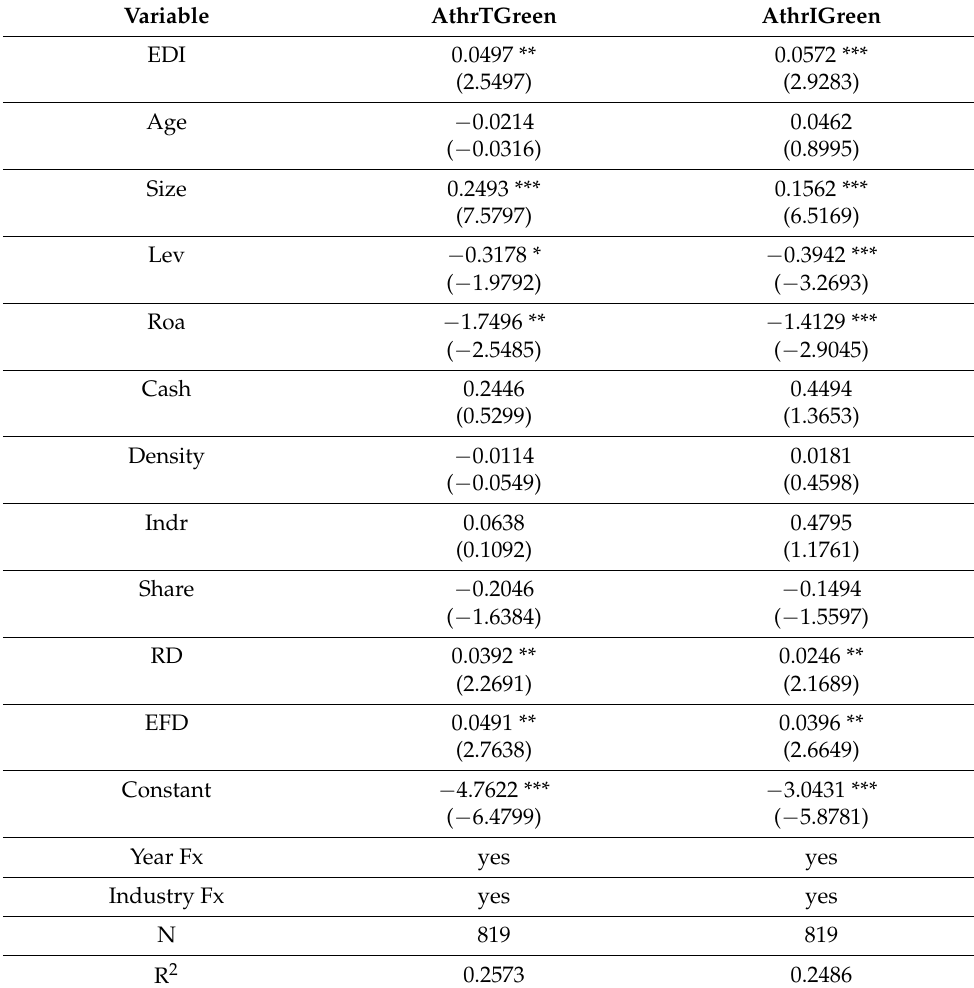
Table 8. Results of the regression analysis of the effect of environmental information disclosures by buyer firms on the number of green patents granted by buyer